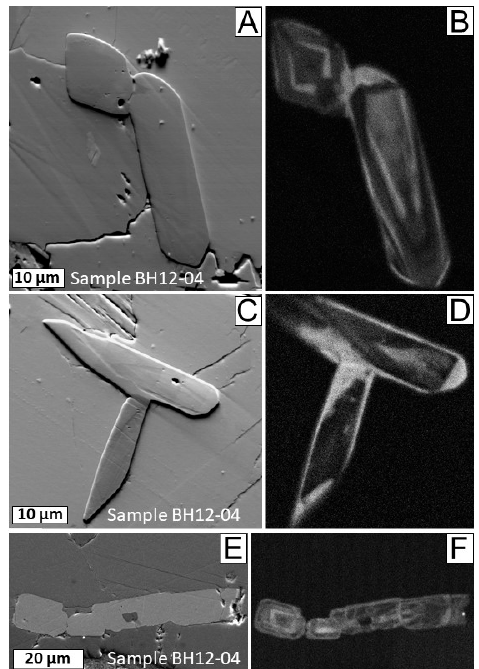
Figure 12. Examples of intergrown zircon crystals from the sample BH12-04. ( A ) Orientation contrast image of the two grains sharing a pyramidal face and forming an L-shaped aggregate. ( B ) CL image of an aggregate, shown in A. Each grain has its independent concentric zoning. ( C ) Orientation contrast image of the two grains forming a T-shaped aggregate. ( D ) CL image of the aggregate, shown in C. ( E ) SE image of a chain of three or four grains. ( F ) CL image of a growth aggregate, shown in E.